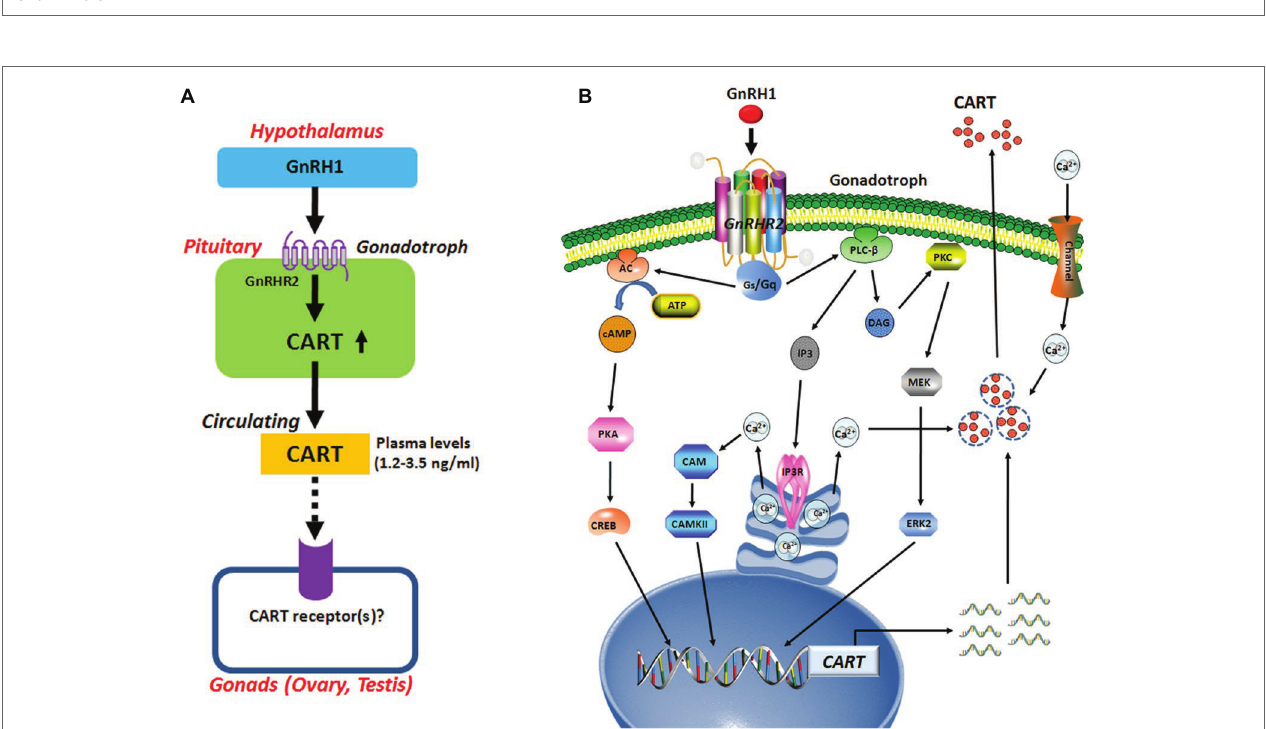
FIGURE 9 | (A) Hypothetic model for gonadotropin-releasing hormone (GnRH)-induced pituitary cocaine- and amphetamine-regulated transcript (CART) expression and secretion, which may act on chicken gonads (ovaries/testes) via an endocrine route. In this model, CART is a novel pituitary hormone, and its secretion into the circulation is potently stimulated by hypothalamic GnRH1 (an ortholog of mammalian GnRH), suggesting that the development and functions of gonads (ovaries/testes) are likely controlled by CART peptide secreted from the anterior pituitary via CART receptor(s), which has not been identified in vertebrates. (B) The signaling pathways involved in mediating GnRH1-induced CART expression and secretion in pituitary gonadotrophs. In this model, GnRH1 stimulates CART expression and/or secretion via activation of GnRHR2 coupled to calcium channel and multiple signaling pathways including Gq-PLC/IP3/Ca 2+ , PKC/MEK/ERK, and Gs-AC/PKA/cAMP signaling